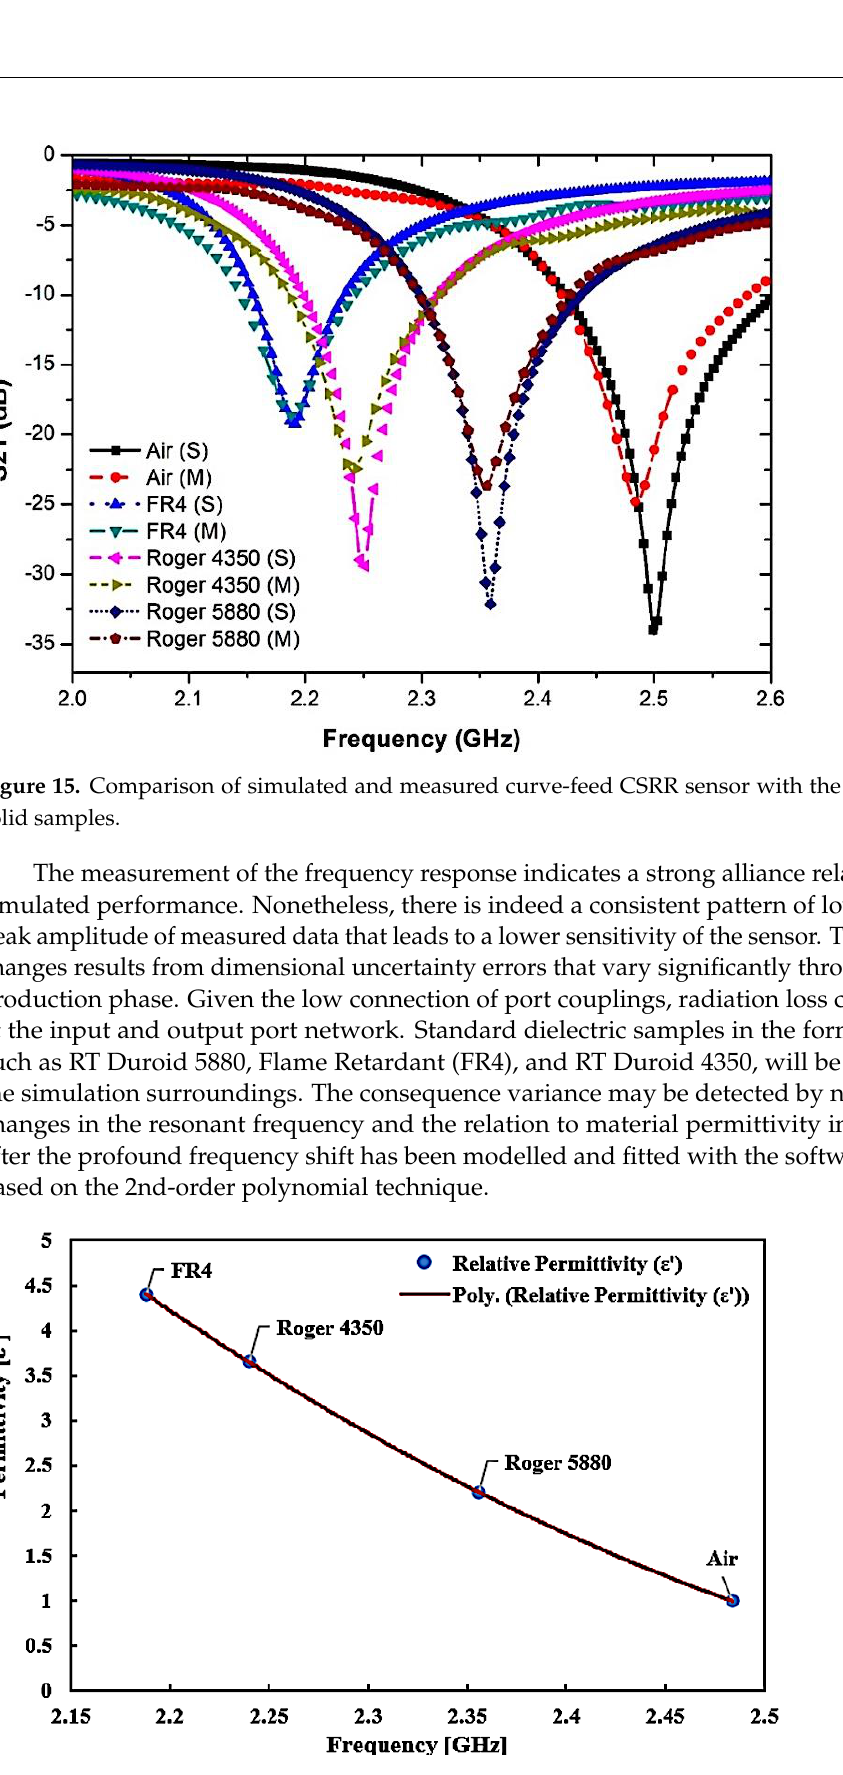
Figure 14. The SUTs prototypes validation for the curve-feed CSRR sensor.